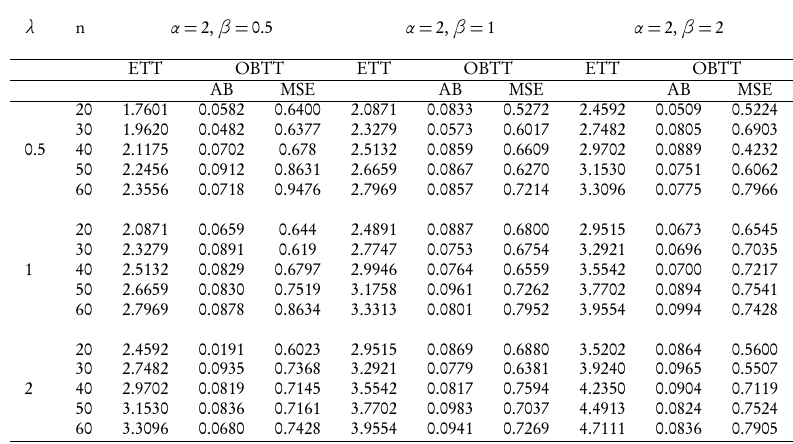
Expected time on test (ETT) and the observed time on test